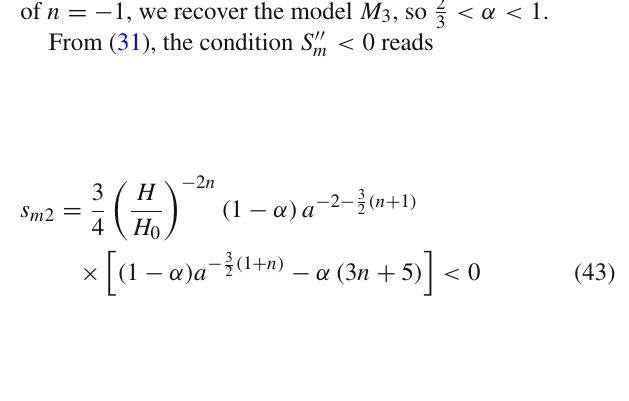
5.4 M 4 : (cid:3) = 3 α H